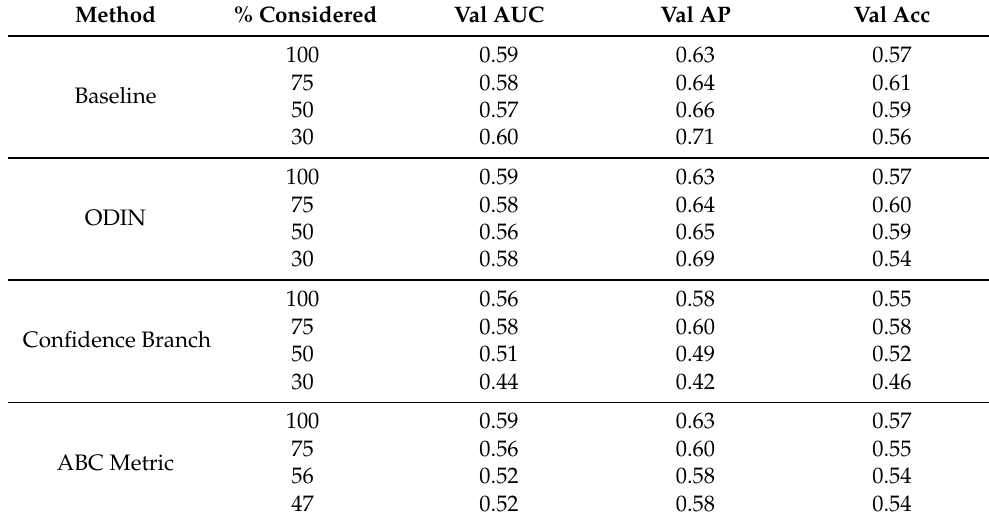
Figure A6. ROC and PR curves for the methylation percentage metric. Tumor-centered, T1wCE only. Table A5. Results of confidence metrics on the validation set. Tumor-centered, FLAIR-T1wCE, early